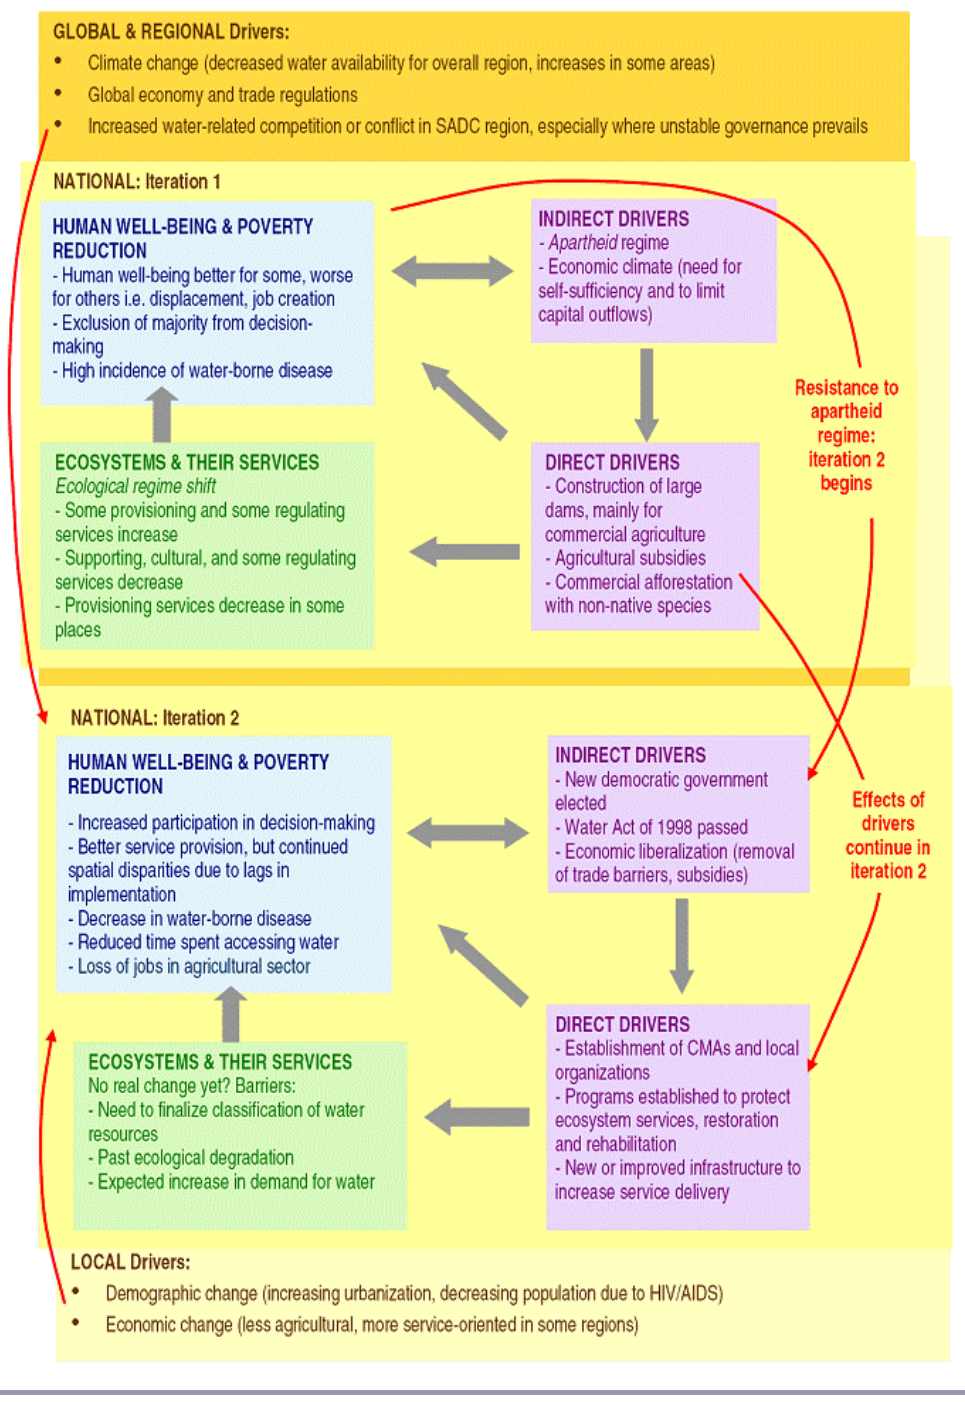
Fig. 1. Adaptation of the Millenium Ecosystem Assessment conceptual framework (MA 2005) to depict two eras of South African water